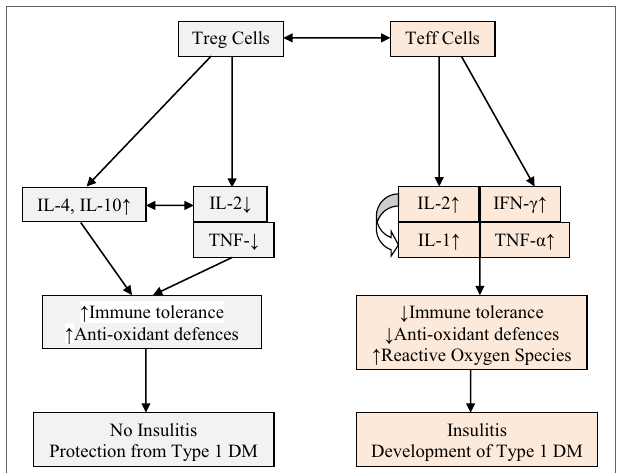
FiGUre 4 | Scheme showing possible role of Treg and Teff cells and cytokines associated with these cells and their role in the prevention or development of type 1 diabetes mellitus (type 1 DM). Low-dose IL-2 and tumor necrosis factor- α (TNF- α ) seem to prevent insulitis and development of type 1 DM by augmenting immune tolerance and enhancing antioxidant defenses in β cells. High levels of IL-2, TNF- α , and interferon- γ (IFN- γ ) are pro-inflammatory in nature, enhance reactive oxygen species (possibly, NO) generation, decrease immune tolerance and antioxidant defenses of β cells, cause insulitis, and eventually lead to the development of type 1 DM (see text for further details). High levels of IL-2 enhance the production of